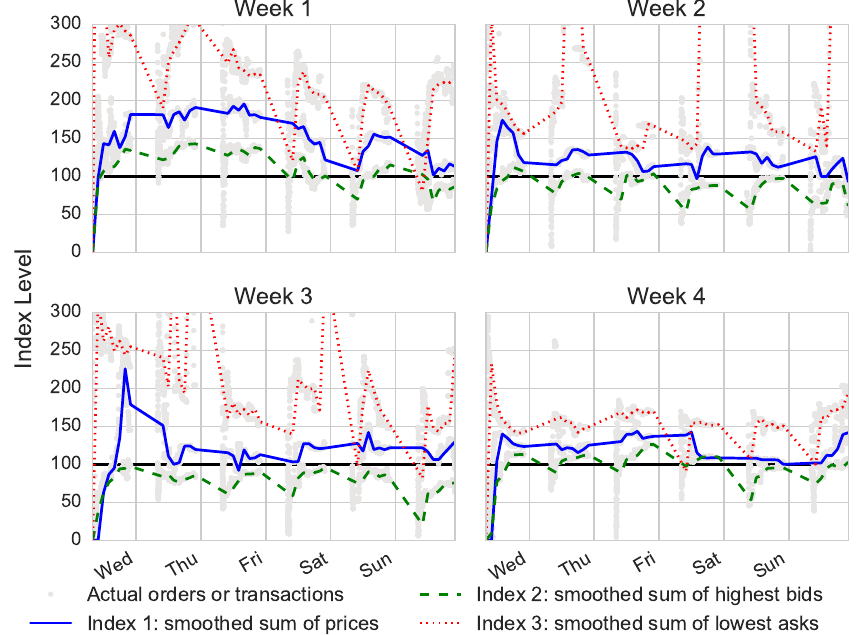
Figure 5: Experiment 2: Evolution of the sum of all security prices for the four weeks of trading. The sum of all security prices should be 100 but there are several pronounced deviations from this normative prediction. The indices are smoothed using a 2-hour moving